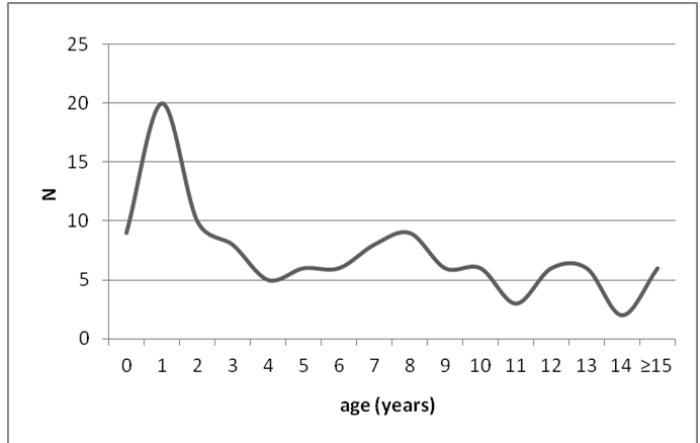
Figure 2. Number of episodes per year of age at PED admission for anaphylaxis. The patients were divided into two groups: (1) children with clear ongoing anaphylaxis symptoms when arriving in the PED (acute patients, [AP], n = 50, 43.1%), and (2) children whose symptoms were in a recovery phase at arrival (non-acute patients, [NAP], n = 66, 56.9%). The mean age of the NAP was 5.5 years, while that of the AP was 8.0 years ( p < 0.01). In the AP group, most of the children were triaged as high priority, but 26% were given a green or white tag; among the NAP, only 24% received a yellow code and none a red one. Thirty-three patients (28.5%) arrived at the PED by ambulance, with no s.s. differences between the AP and